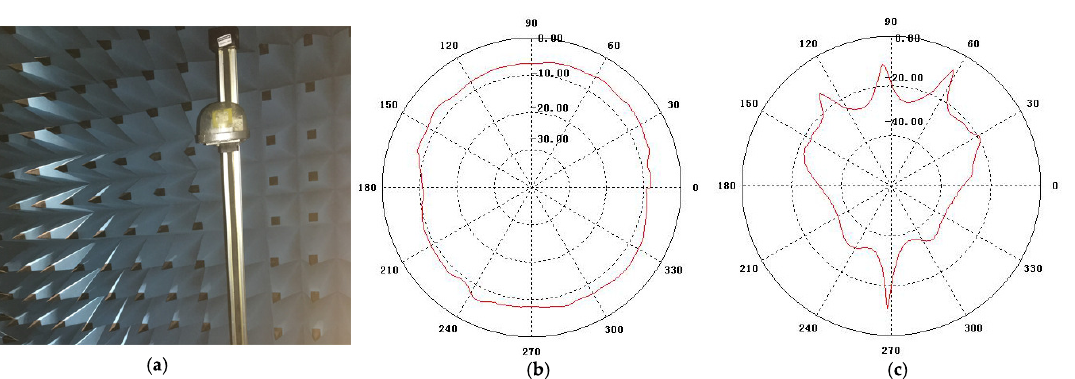
Figure 1. Structure of the transmitted signal.